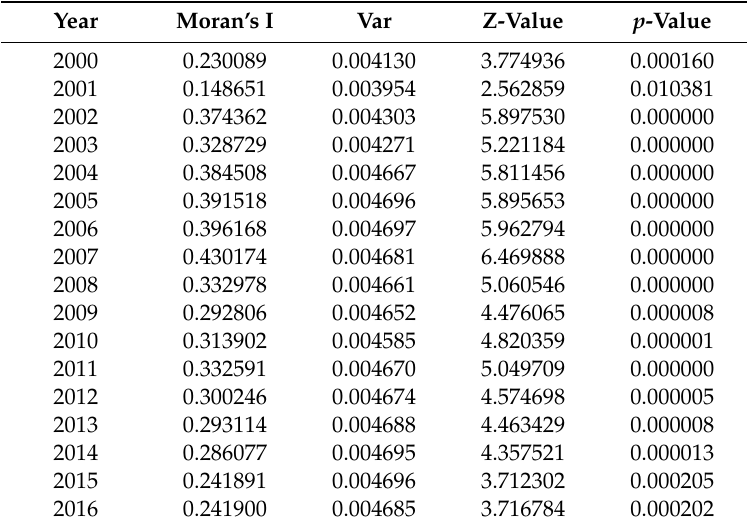
Table 5. Global Moran’s I of Agricultural Land Use Intensity in Hubei Province from 2000 to